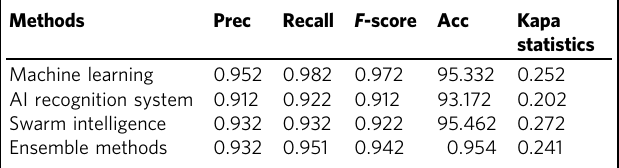
Table 1 Comparison of diff